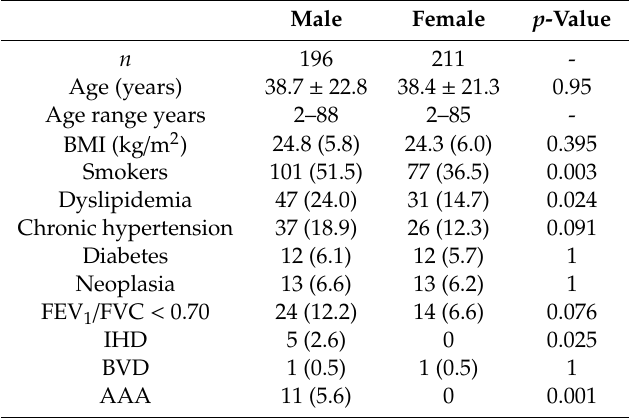
Table 1. Demographic characteristics of the individuals included in the study, by gender.